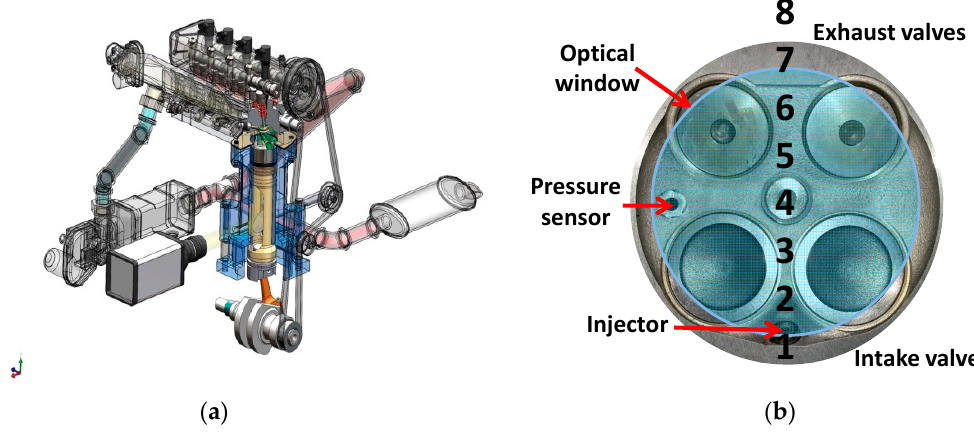
Figure 1. Schematic representation of ( a ) the experimental setup and ( b ) bottom field of view of the combustion chamber with the locations of the spectroscopic region of interest. Table 1. Engine specifications.